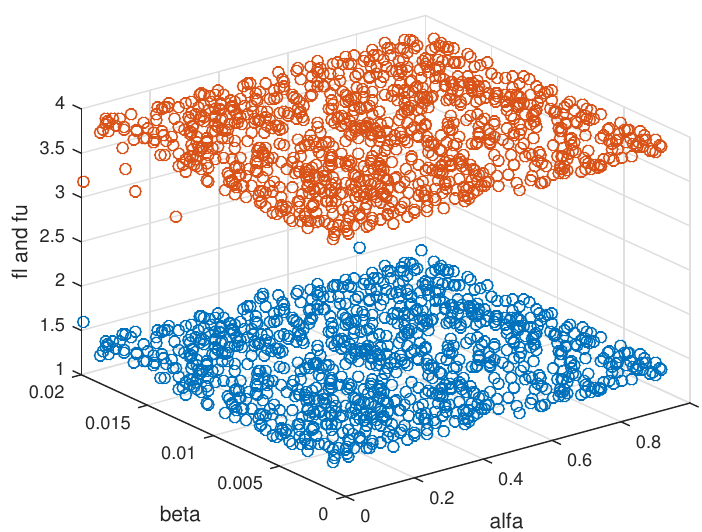
Figure 6. Efficient space for Example 3 without SOC constraint using n =